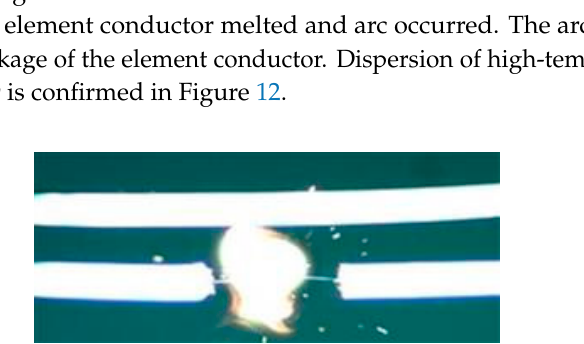
Figure 12. Arc observed at the time of breakage of an element conductor.